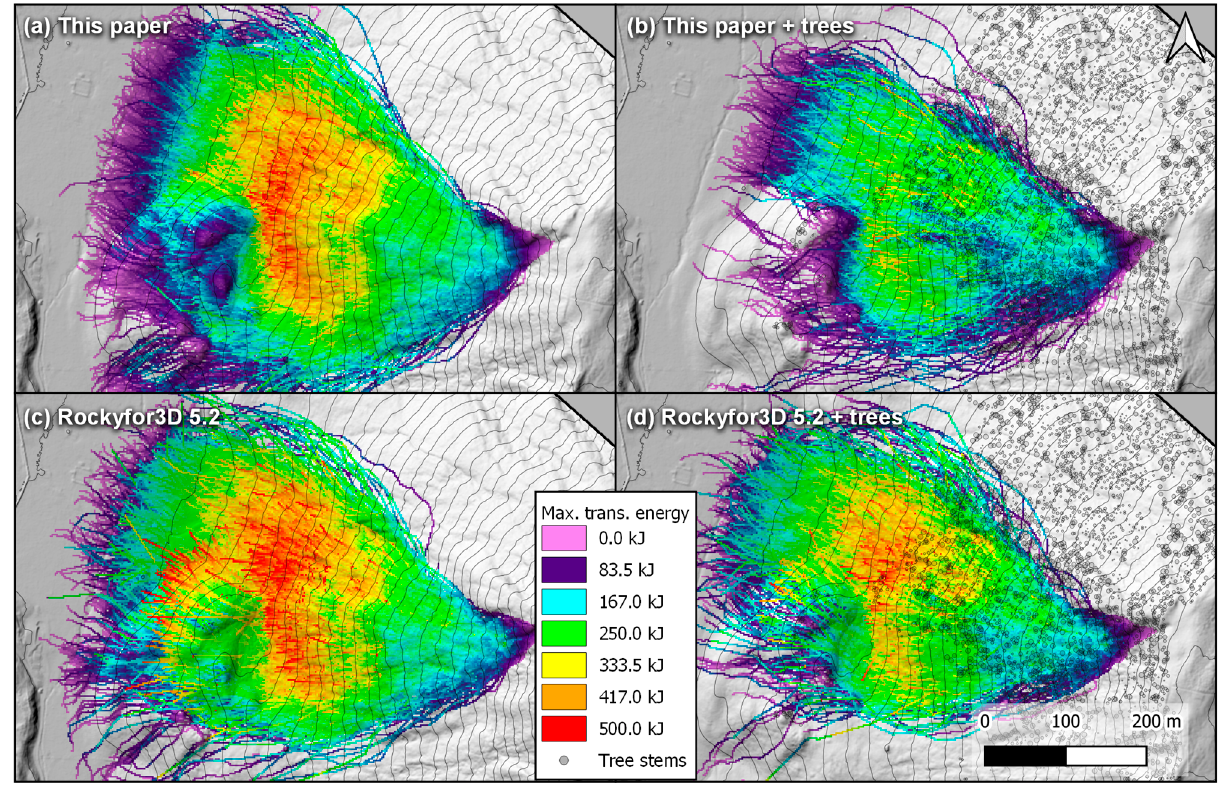
Figure 25. Results for the comparison on the alpine slope near La Verda–Rougemont in Switzerland. The left windows ( a , c ) show the maximum translational kinetic energy results from the proposed algorithm compared to those from Rockyfor3D 5.2.15. The right windows ( b , d ) show the same results but consider the tree stems. The 10 m contour lines and hill shade base layers are from a 1 m cell size gridded DTM.